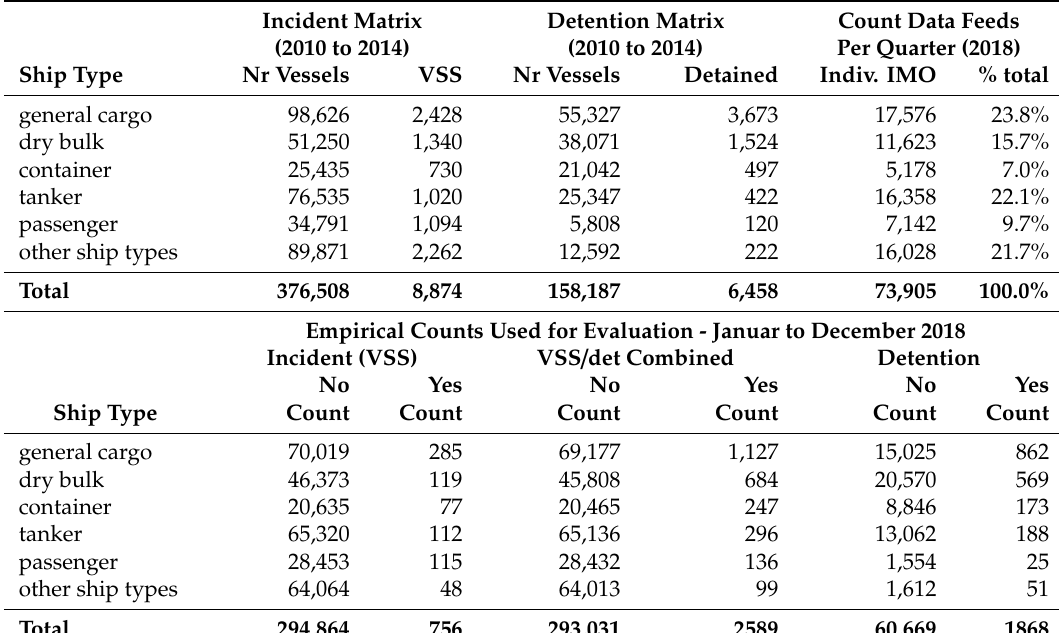
Table A1. Descriptive statistics by ship type of data sets and data feeds